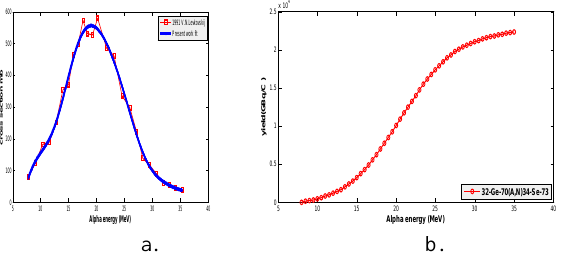
Figure 8: a. Excitation function for the reaction 70 Ge (α,n) 73 Se. b. Isotopes production yield for the reaction 70 Ge (α,n) 73